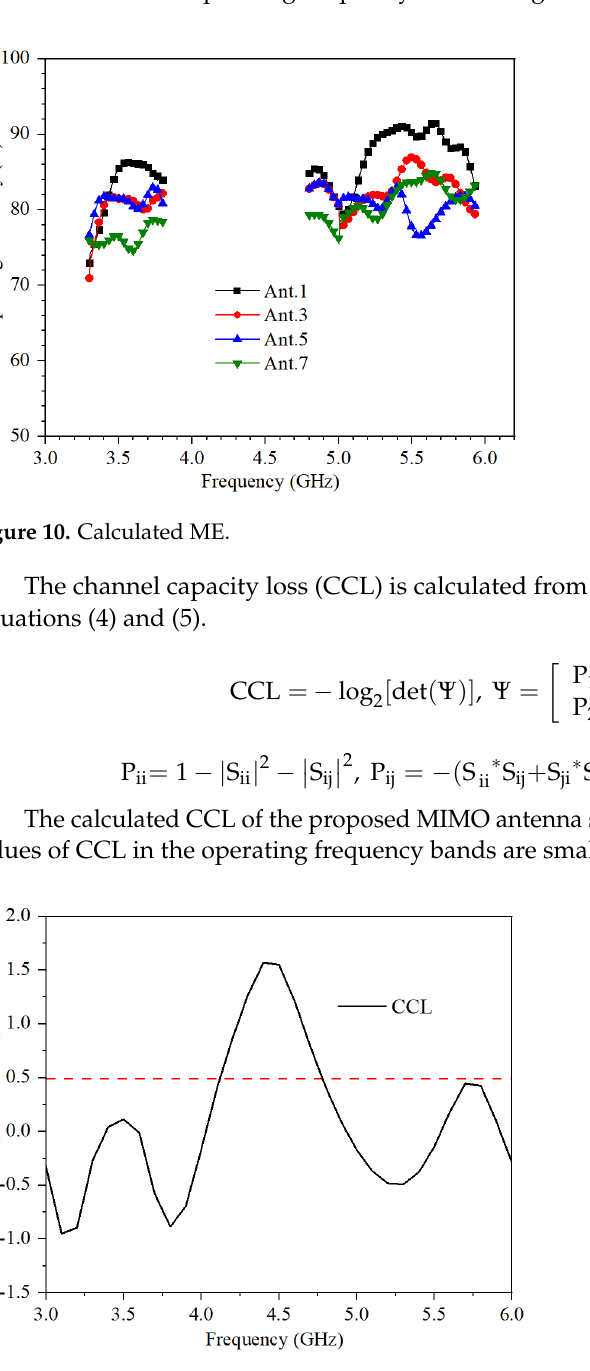
Figure 11. Calculated DG. The total active reflection coefficient (TARC) is calculated from S-parameters in Equation (6).